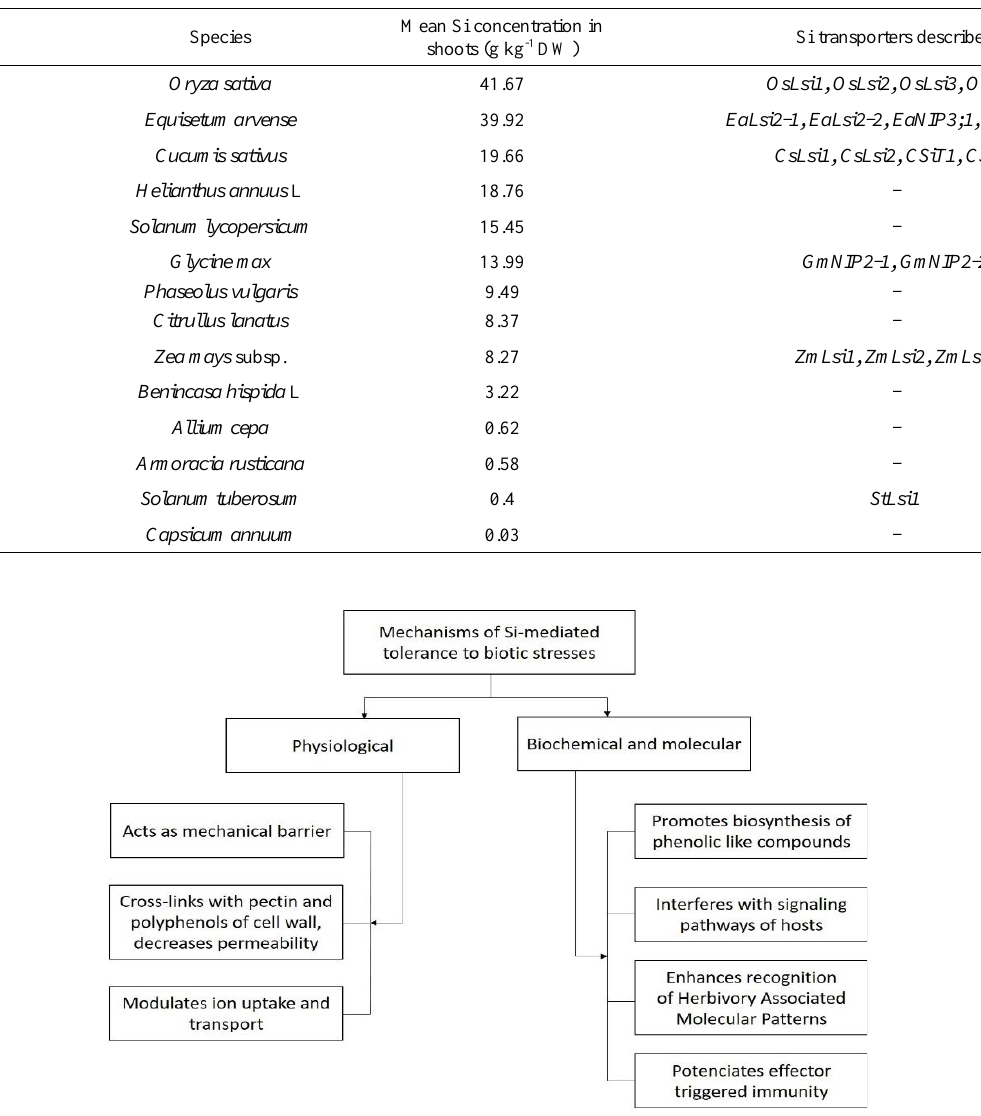
Table 1. Si concentration and Si transporters identified in some important crops